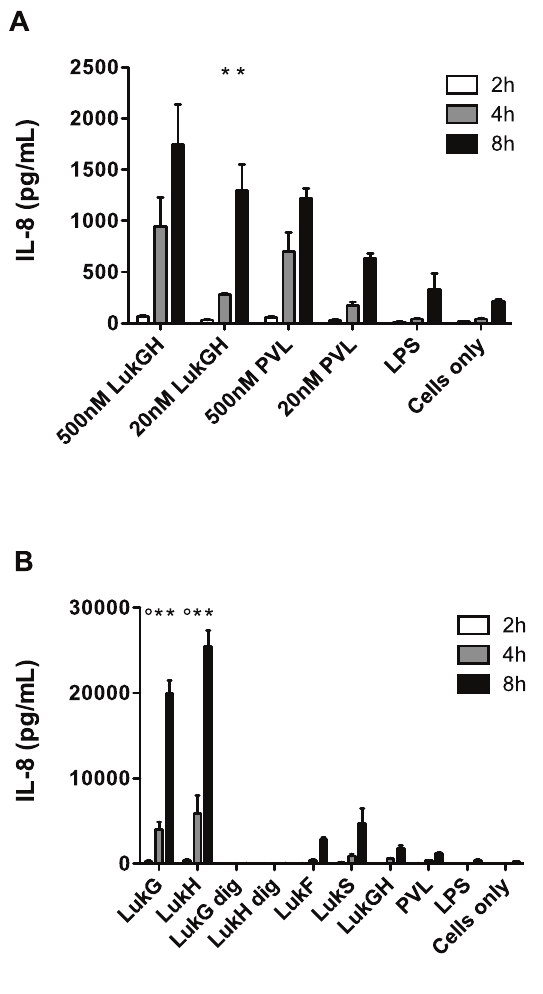
Figure 7. IL-8 production by PMNs treated with LukGH or PVL. PMNs (2 6 10 6 /mL) were incubated in the presence or absence of (A) indicated concentrations of LukGH, PVL, LPS (50 m g/mL) and (B) single leukotoxin components, protease-digested single components (LukG dig and LukH dig), LukGH, PVL (all 500 nM) or LPS (50 m g/mL) for 2–8 h. IL-8 levels in the supernatants were measured by ELISA using recombinant IL-8 as a standard. The results represent the mean of three independent experiments 6 SEM. In (A), * indicates statistical significance compared to PVL. In (B), * indicates significance compared to both LukF-PV and LukS-PV and 6 indicates significance to LukF-PV only.